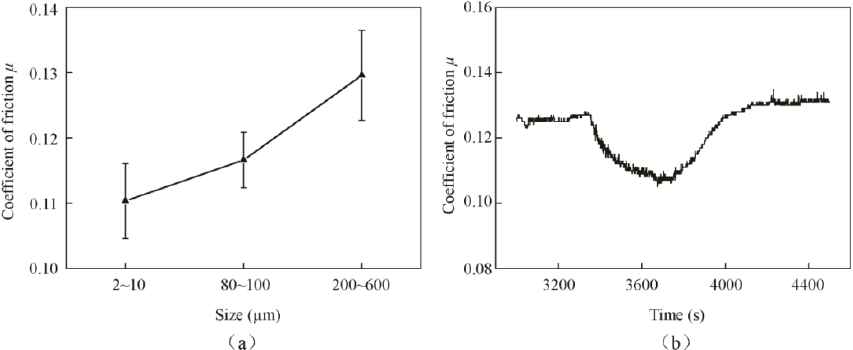
Figure 15. SEM images of lamellar MoO 3 with a ( a ) small size of 2~10 μm and ( b ) a medium size of